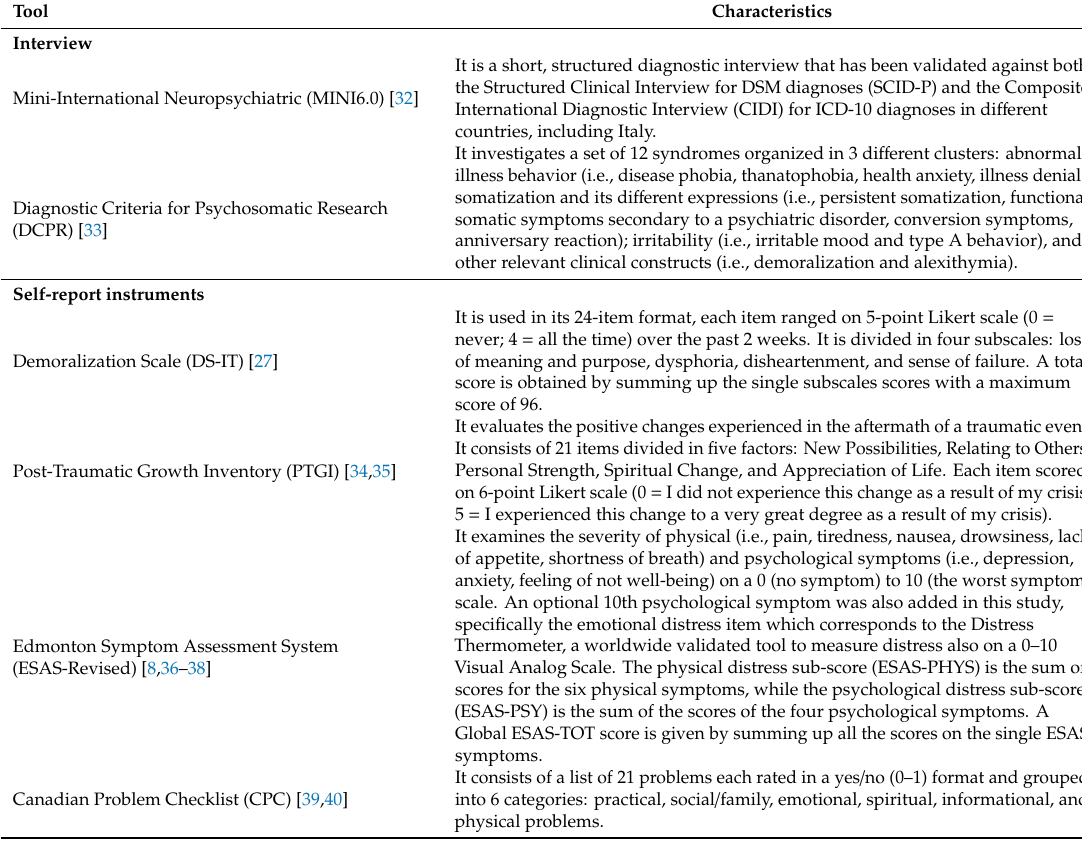
Table 1. Features of interviews and self-report instruments used in the